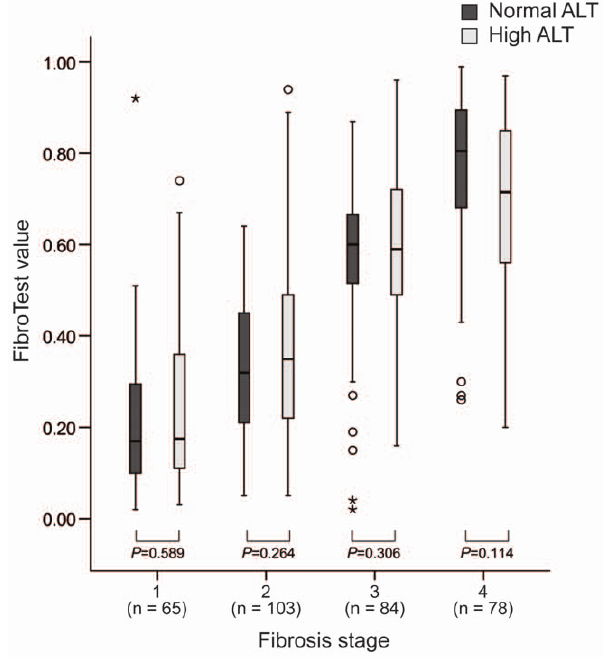
Figure 5. FT values between patients with normal ALT and those with high ALT in each fibrosis stage. FT values were statistically equivalent between two groups (all P . 0.05).